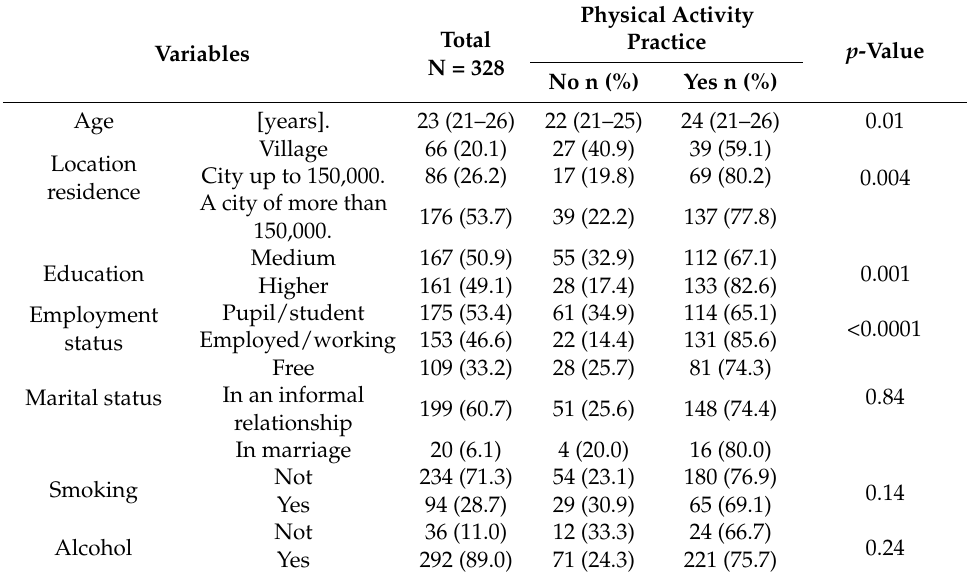
Table 1. Characteristics of respondents by physical activity